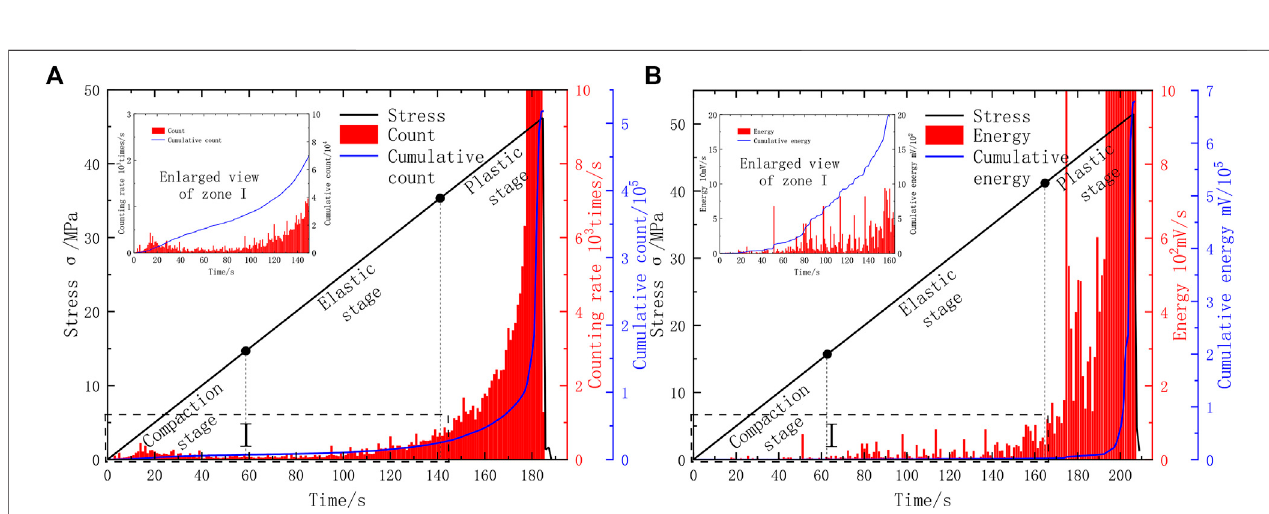
FIGURE 9 | Relationship between acoustic emission counting and cumulative counting of rock samples and stress: (A) Unanchored bedding sandstone; (B) Anchored bedding sandstone.